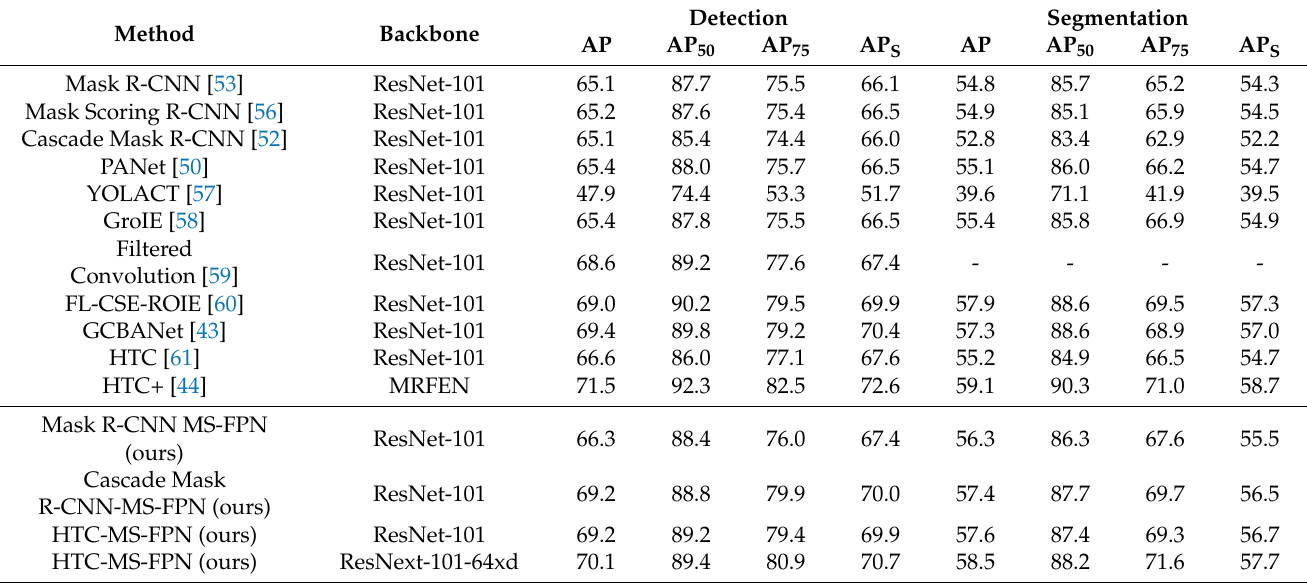
Table 7. The comparison results with other advanced